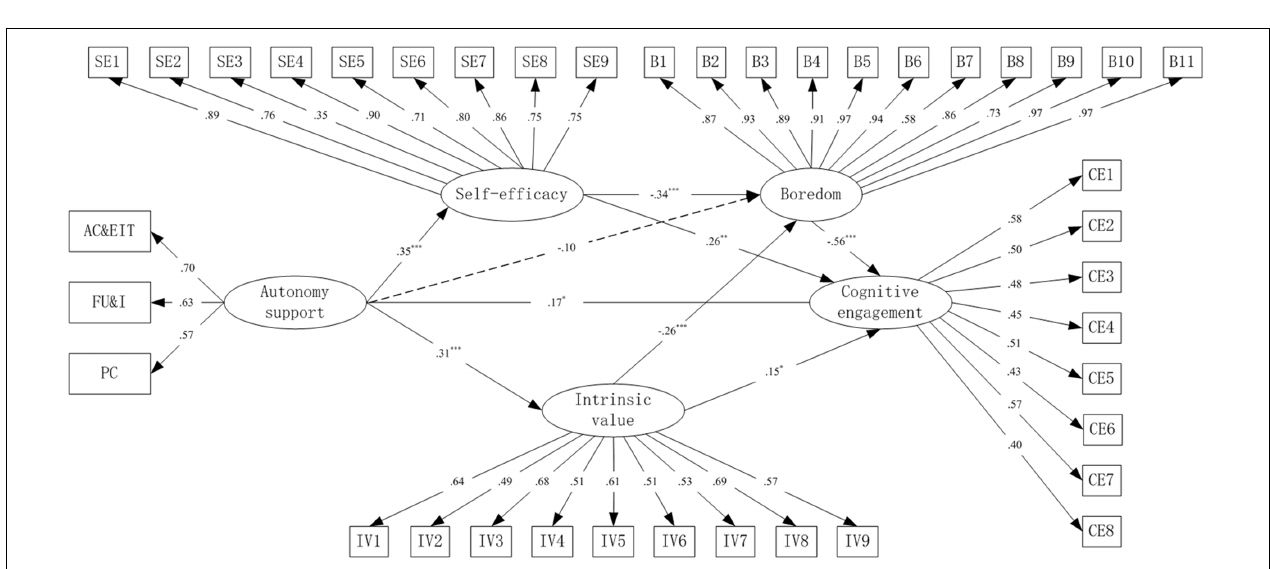
FIGURE 4 | Full mediation model for cognitive engagement as dependent variable. PC, providing choice; FU&I, fostering understanding and interest; AC&EIT, allowing criticism and encouraging independent thinking; SE1–SE9, nine items of self-efficacy; IV1–IV9, nine items of intrinsic value; B1–B11, 11 items of boredom; CE1–CE8, eight items of cognitive engagement. ∗∗∗ p < 0.001; ∗∗ p < 0.01; ∗ p < 0.05.